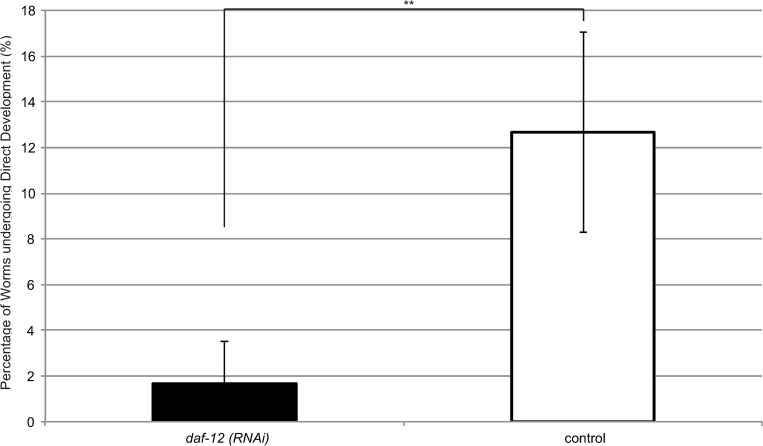
Suppression of daf-12 significantly reduces the ability of worms to undergo direct development to infective larvae.Young worms were soaked with an siRNA targeting daf-12 (daf-12(RNAi)) or a scrambled siRNA (control), and the proportion of females which developed to infective larvae after 3 days was determined. Males were excluded from this analysis as they cannot undergo direct development. Error bars represent standard deviation. This figure shows the mean value comprised from 3 biological replicates with 4 technical replicates per biological replicate. Mann Whitney U analysis was performed to determine statistical analysis. ** indicates a highly statistically significant p-value of less than 0.001 (p<0.0001).